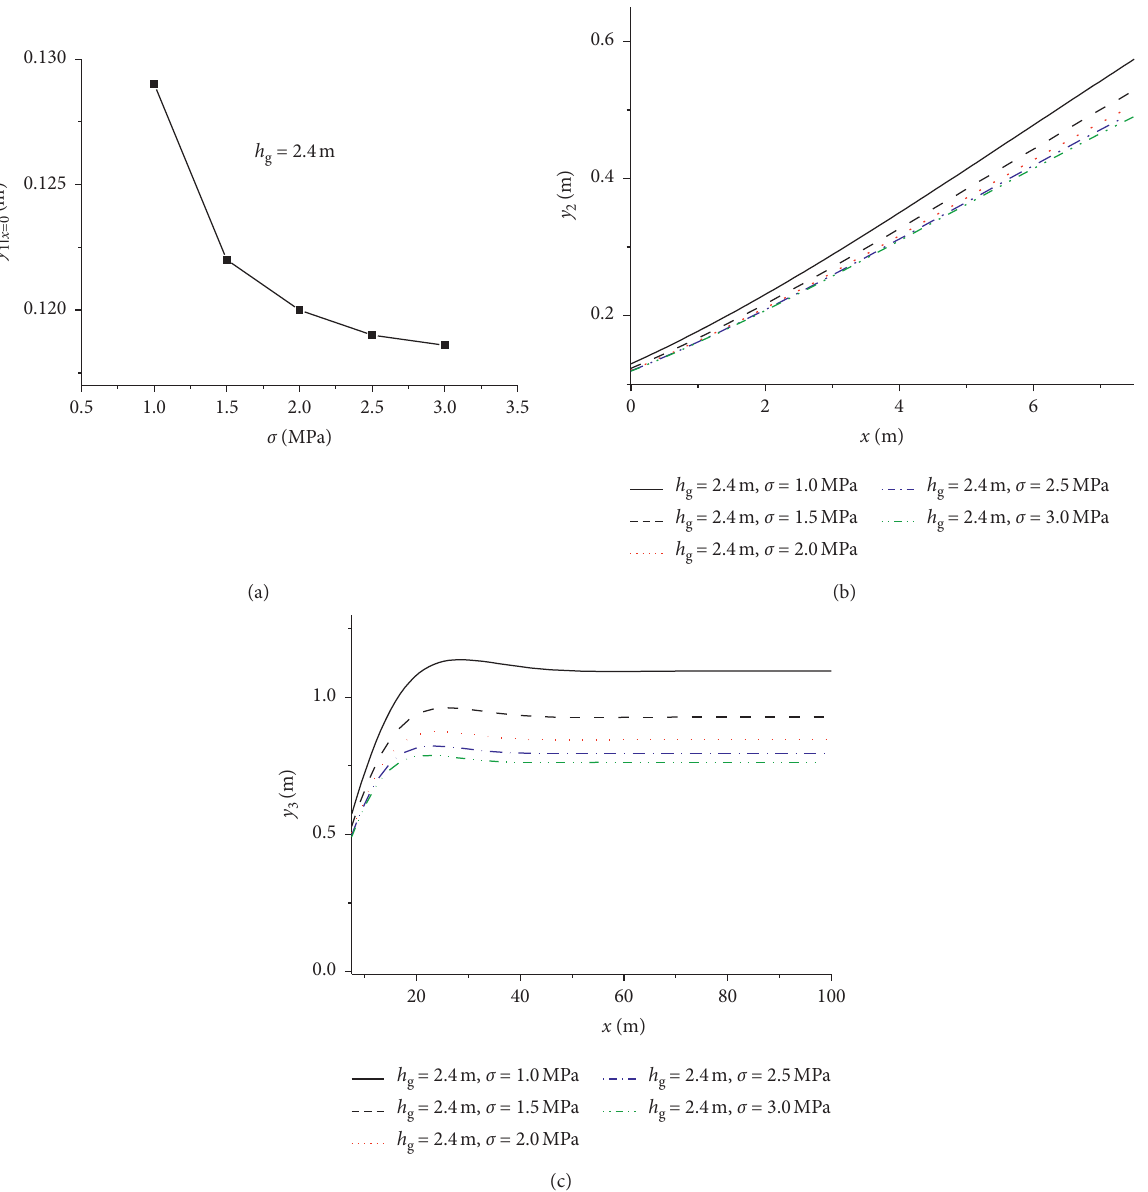
Figure 3: Roof’s subsidence with different σ . (a) Roof’s subsidence of coal wall. (b) Roof’s subsidence above the support. (c) Roof’s subsidence above the gangue filling